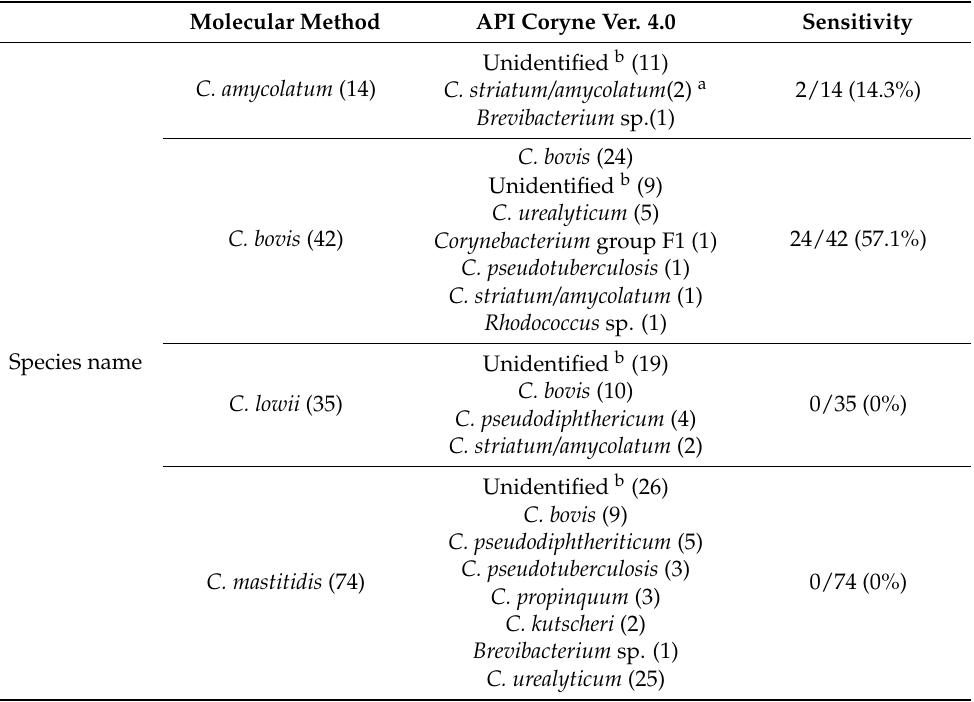
Table 2. Comparison of results of biochemical tests with molecular methods for identifying Corynebacterium spp.